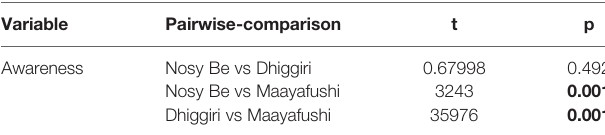
TABLE 3 | Pairwise comparison a among locations for the variable awareness.